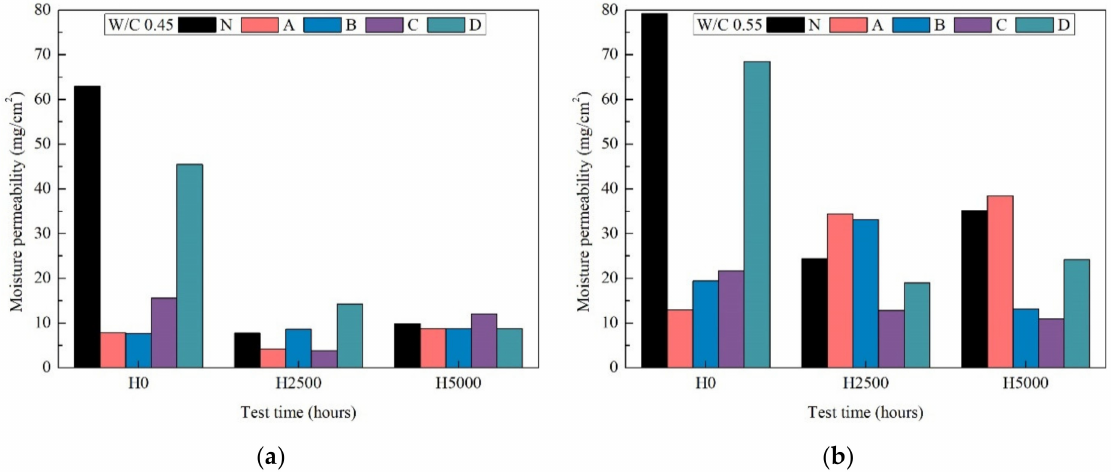
Figure 8. The moisture permeability test after 0 h, 2500 h and 5000 h weathering of w/c ratio 0.45 ( a ) and 0.55( b